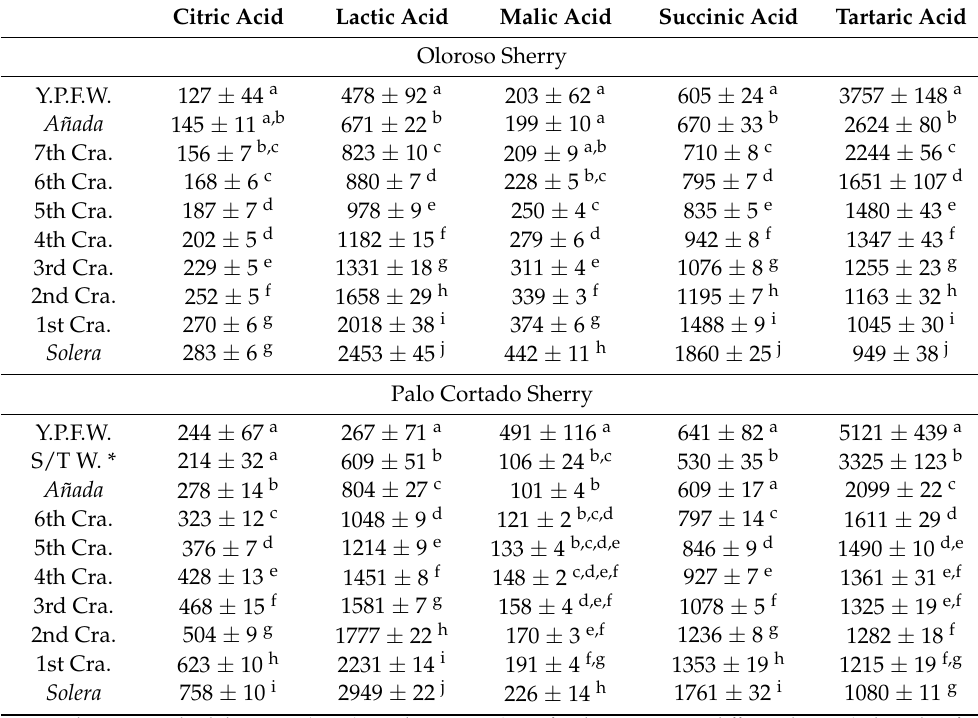
Table 5. Organic acids (mg/L) in the Oloroso and Palo Cortado Sherry wines studied. Citric